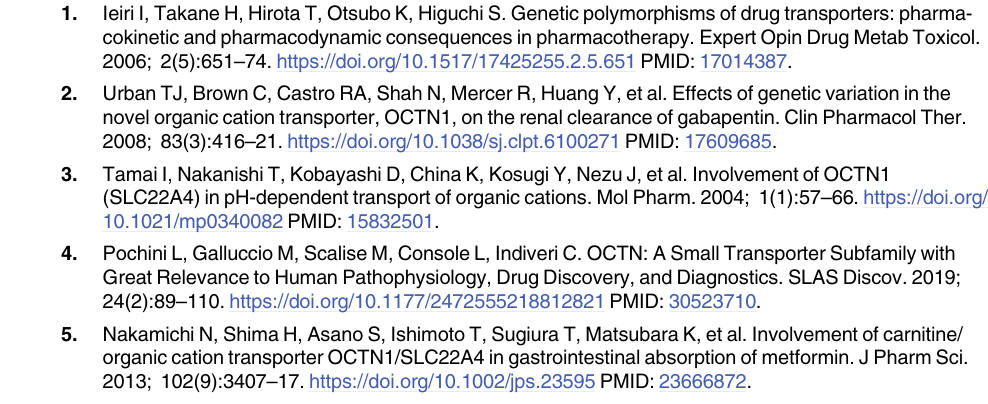
S1 Table. Comparison of baseline demographics and clinical characteristics among differ- ent genotypes of OCTN1 rs1050152. S2 Table. Comparison of baseline demographics and clinical characteristics among differ- ent genotypes of OCTN1